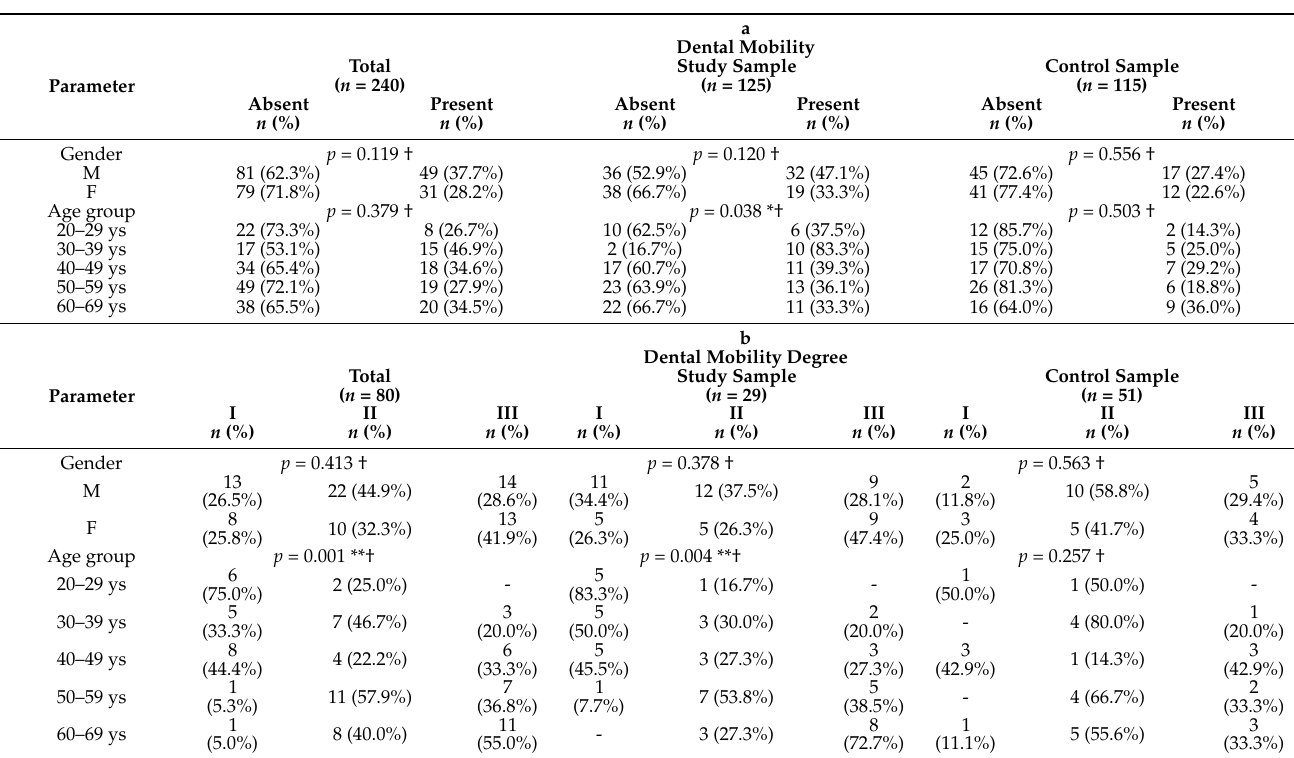
Table 2. a. The dental mobility presence by genders and age groups in the investigated samples. b. The dental mobility degree by genders and age groups in the investigated